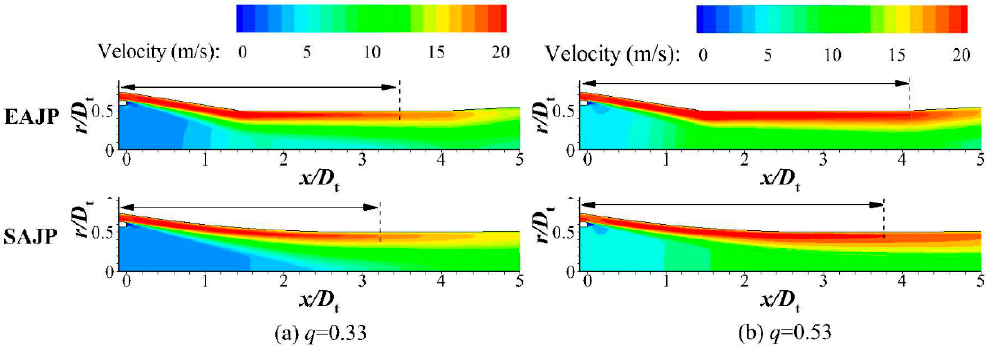
Figure 10. Velocity distribution.